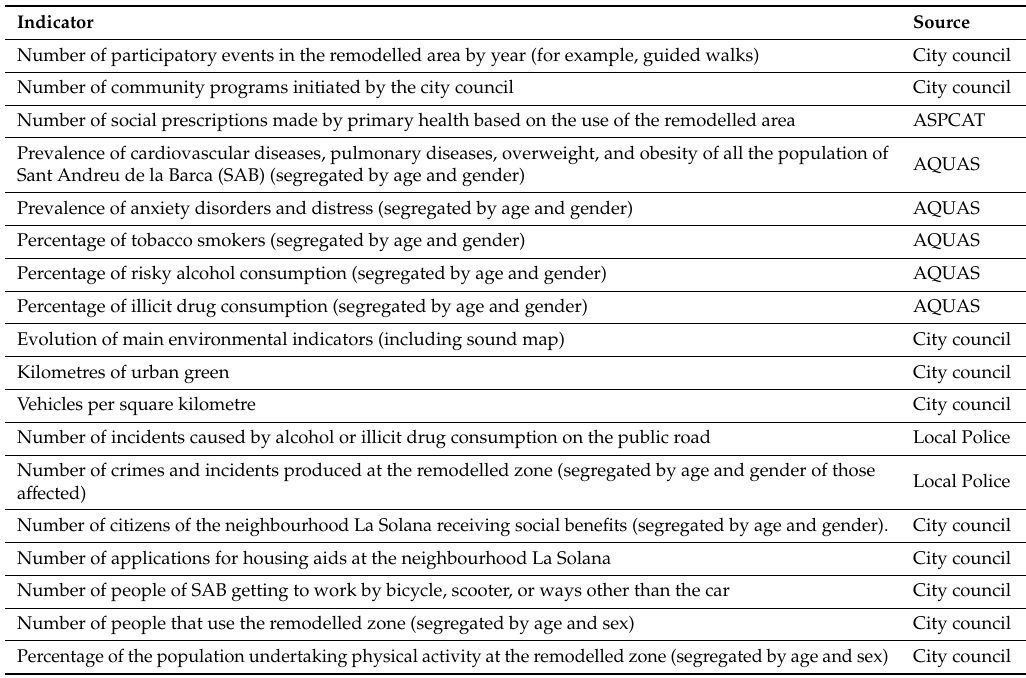
Table 4. Health Impact Assessment (HIA) evaluation: selected indicators and source of